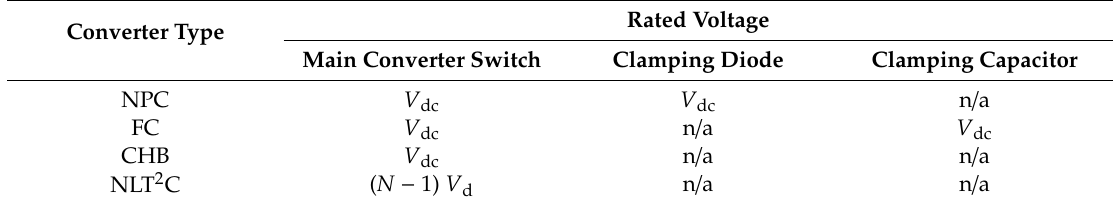
Table 9. Comparison of neutral point clamped (NPC), cascaded H-bridge (CHB), flying capacitor (FC), and NLT 2 C in terms of rating requirement per the N